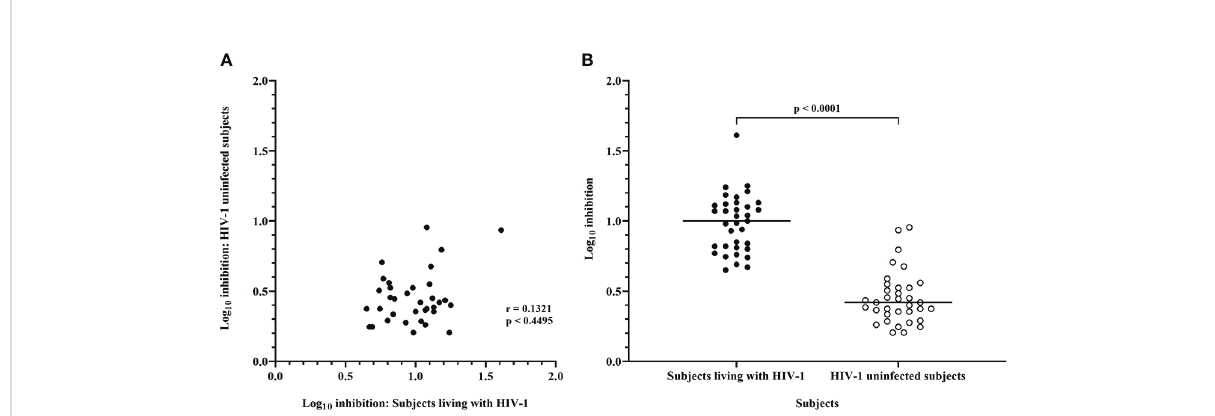
FIGURE 4 Inhibition mediated by CD8 T-cells from ART naive subjects living with HIV-1 and HIV-1 uninfected subjects. (A) Spearman correlation between inhibition of HIV-1 IMC-LucR in ART naive subjects living with HIV-1 or HIV-1 uninfected subjects. (B) Scatter plot of the same data with medians of the groups (bar) and p value generated with a Wilcoxon test. Each data point represents the median log 10 inhibition of an IMC-LucR mediated by CD8 T-cells from ART naive subjects living with HIV-1 or HIV-1 uninfected